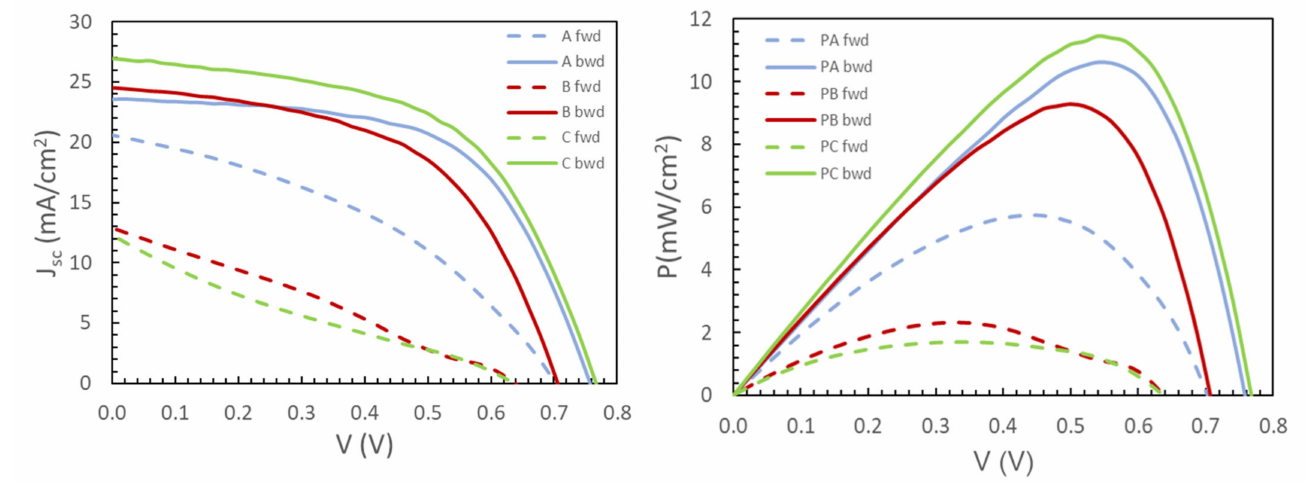
Figure 2. Current density-voltage (J–V) (left) and power density-voltage (P–V) (right) curves of the best MAPI perovskite solar cell with 5–AVAI additives, with different weight concentrations: 1% (A), 5% (B) and 3% (C), all of them showing hysteresis between the forward (slashed line) and backward (continuous lines)